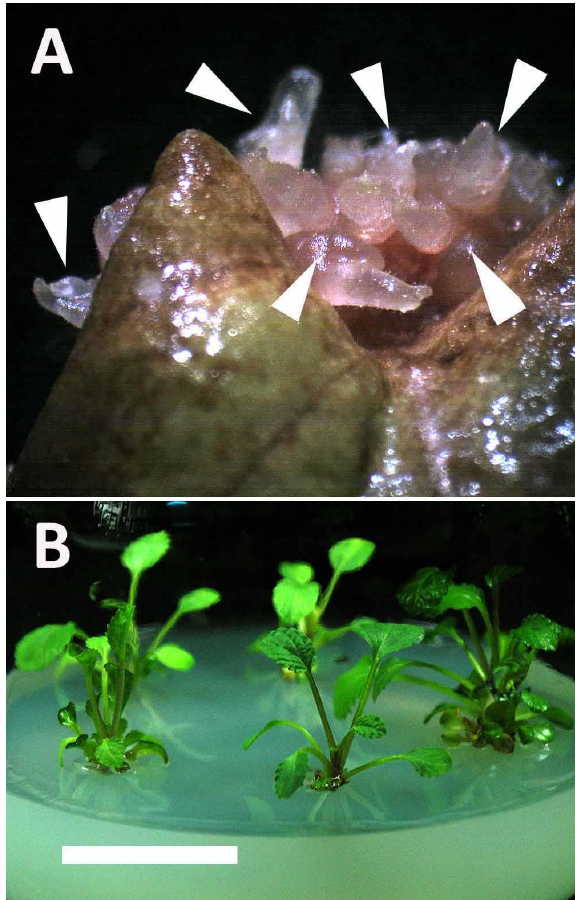
Figure 1. Induction of polyploids via TDZ-induced direct organogenesis from leaf explants of Salvia miltiorrhiza on colchicine-containing medium (bar = 5 and 14 mm for Figure 1A,B, respectively). ( A ) Shoot buds (arrowhead) formed directly from the leaf explants after eight weeks of culture. ( B ) Shoot-derived plantlets after 17 weeks of culture. Molecules 2018 , 23 , x